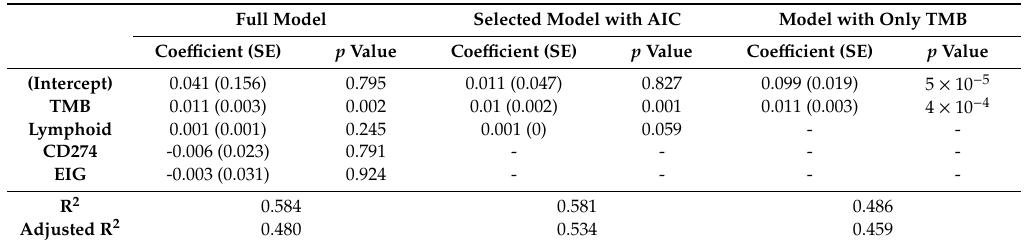
Table 1. Summary of multivariate linear regression including TMB, EIG, PD-L1 expression, and lymphoid score to estimate the objective response rate (ORR). The best model was selected by the Akaike information criterion (AIC). TMB: tumor mutational burden; EIG: expanded immune gene signature. Full Model Selected Model with AIC Model with Only TMB Coe ffi cient